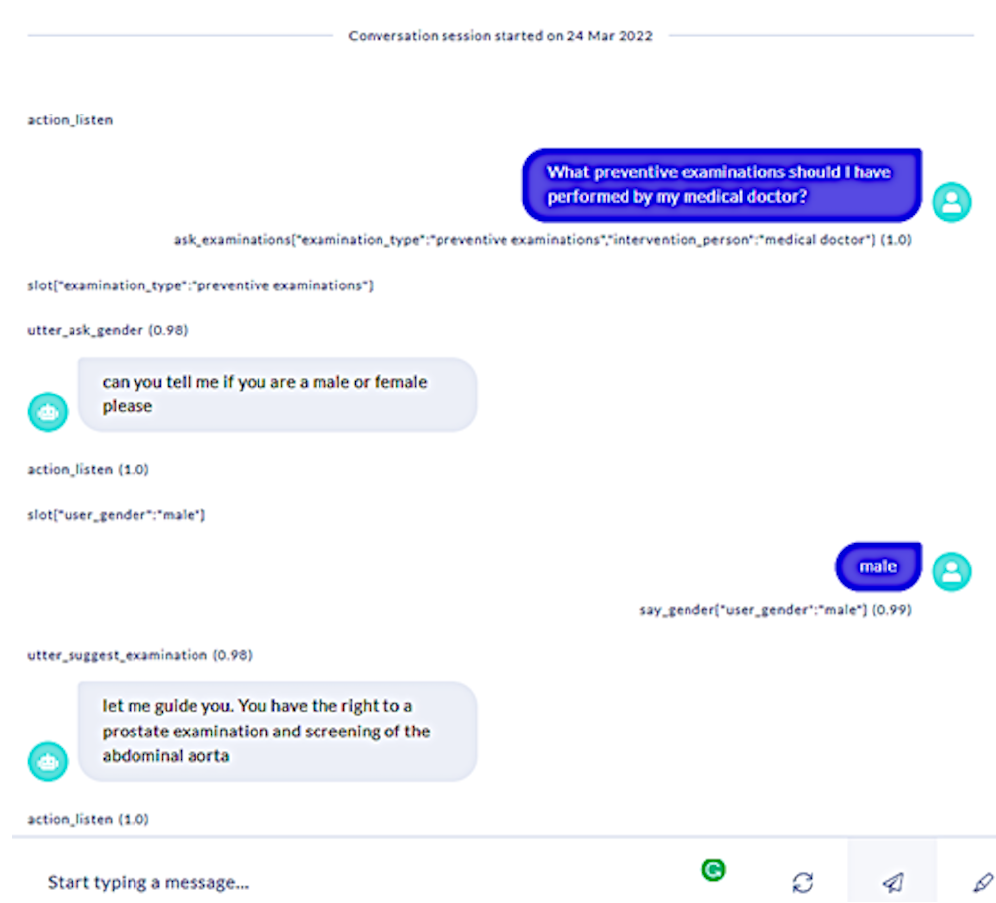
Figure 7. Screenshot of dialogue in the medical prevention